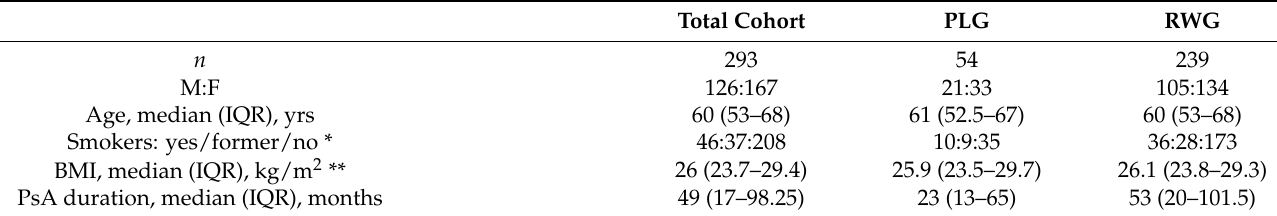
Table 1. Baseline characteristics of PsA